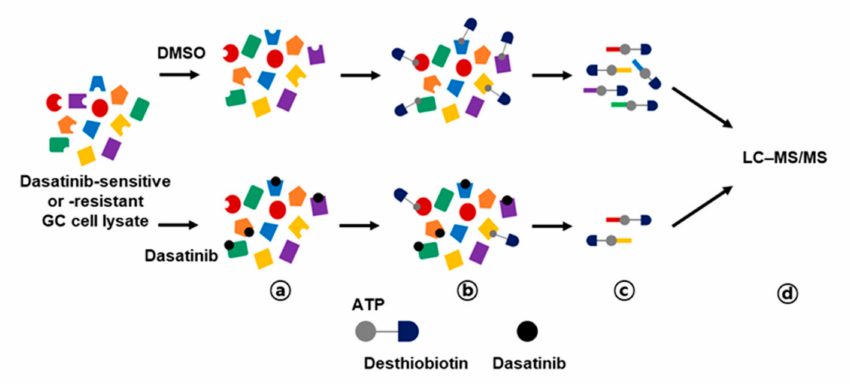
Figure 3. Workflow for dasatinib target profiling via ATP probe-based activity-based protein profiling (ABPP) in GC. Cell lysates from dasatinib-sensitive (MKN-1 and SNU-216) and -resistant (SNU-484 and SNU-601) GC cell lines were preincubated with vehicle control (DMSO) or 10 µ M of dasatinib (a), then reacted with desthiobiotin-ATP probe (b). Subsequently, cell lysates were trypsin digested and labeled peptides were purified by streptavidin agarose beads (c). Probe-labeled peptides were analyzed by LC–MS / MS